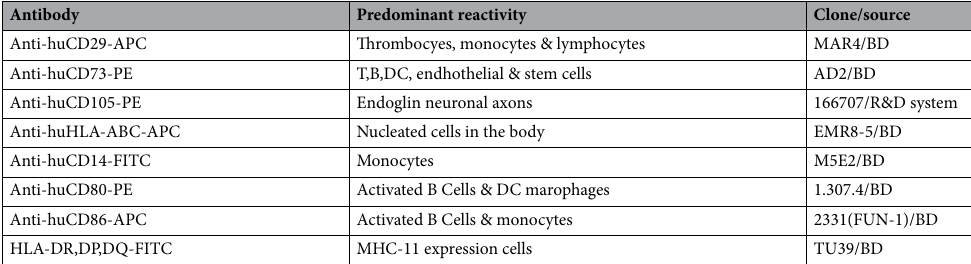
Table 1. Mouse raised against human MAb used in flow cytometry analsysis. The antibodies were purchased from Benton Dickinson except CD105 which was purchased from R&D System. hu human, APC allophyceoerythrin, DC dendritic cells, FITC fliorescein isothiocynate, PE phycoerythrin.